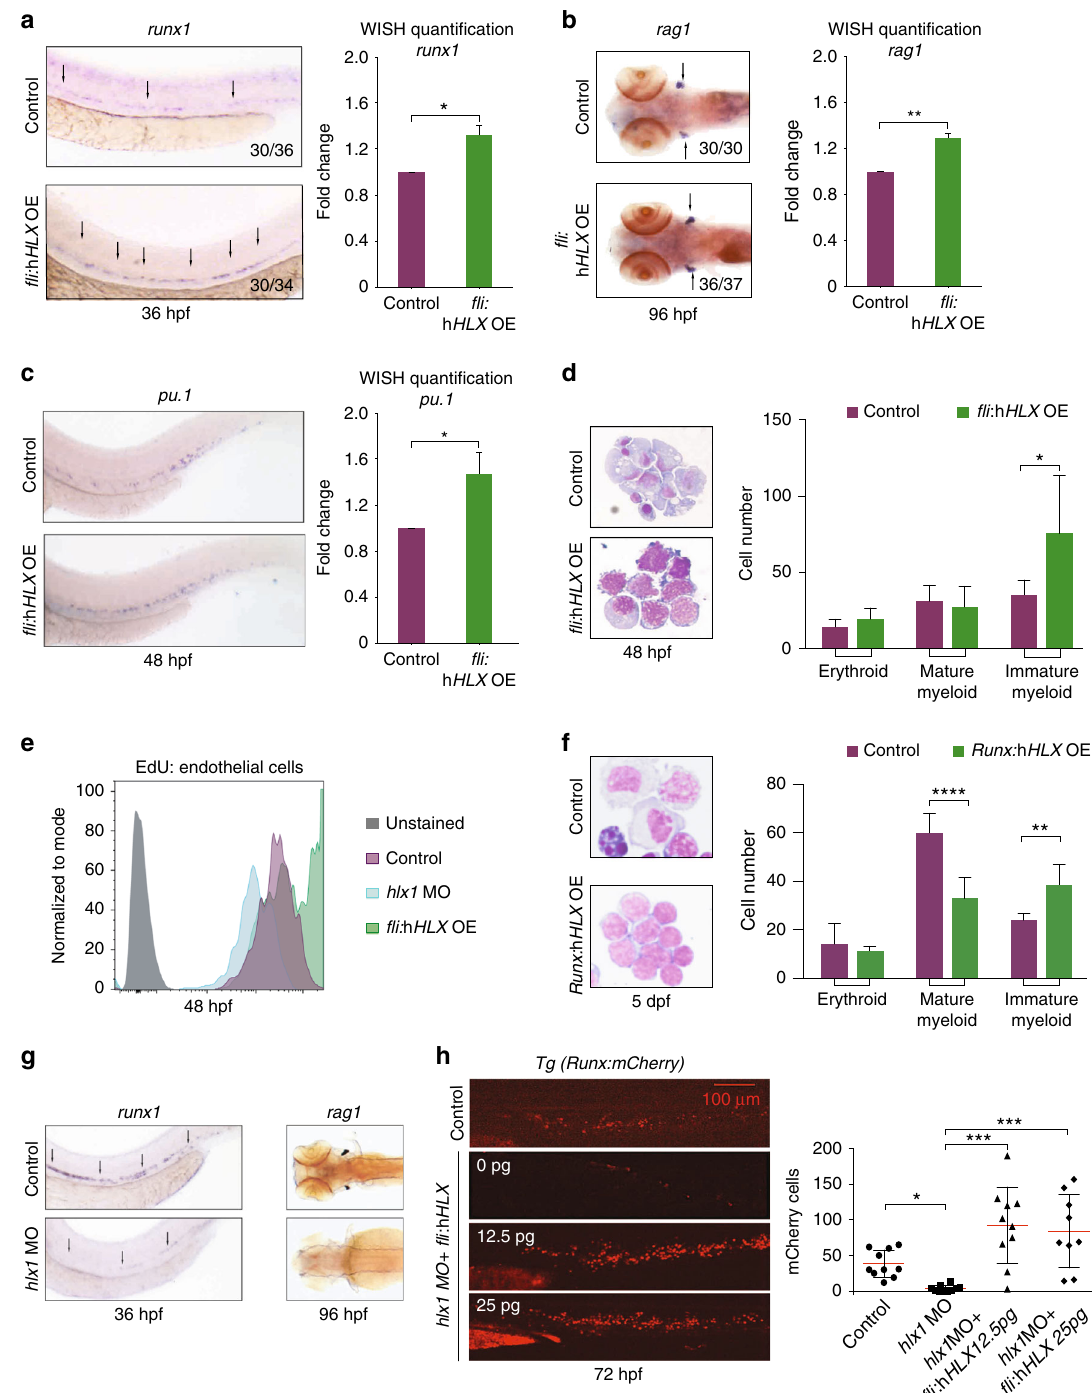
(negative binomial test (NBT), P < 0.05) in fl i :h HLX OE embryos (Fig. 2a, Supplementary Fig. 2a, and Supplementary Data 1). On the other hand, 942 genes were downregulated and 1162 genes upregulated over two-fold (NBT, P < 0.05) in hlx1 MO animals (Fig. 2a, Supplementary Fig. 2a, and Supplementary Data 1). Seventy-nine (8%, hypergeometric test (hg.t), P < 0.01) of the downregulated genes in hlx1 MO were inversely correlated in fl i